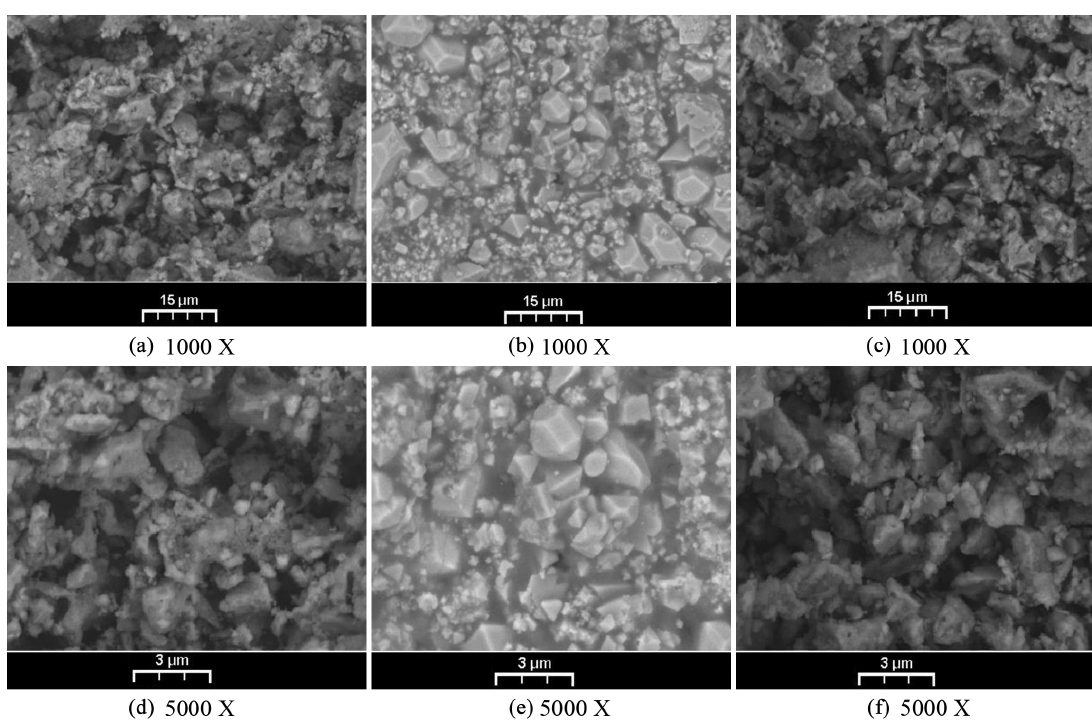
Figure 8. SEM images of the: (a) and (d) Li for 120 min. Table 1. Specific surface area data (B.E.T.) for Li